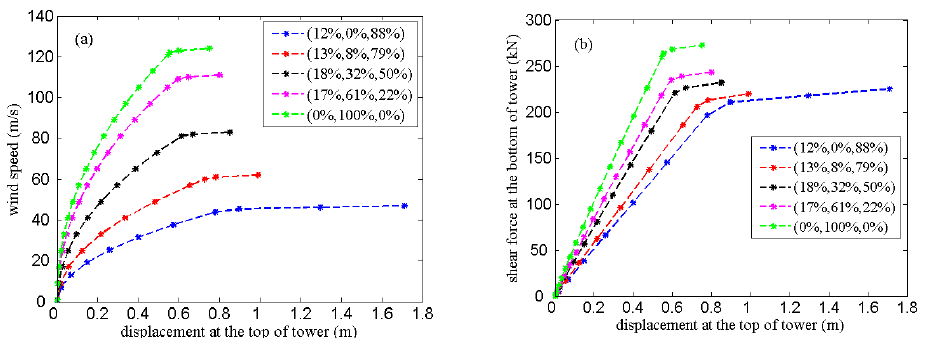
Figure A1. Capacity curves of tower ZY under different wind loading cases. ( a ) the curve relating the displacement to the wind speed; ( b ) the curve relating the displacement to the bottom shear force.